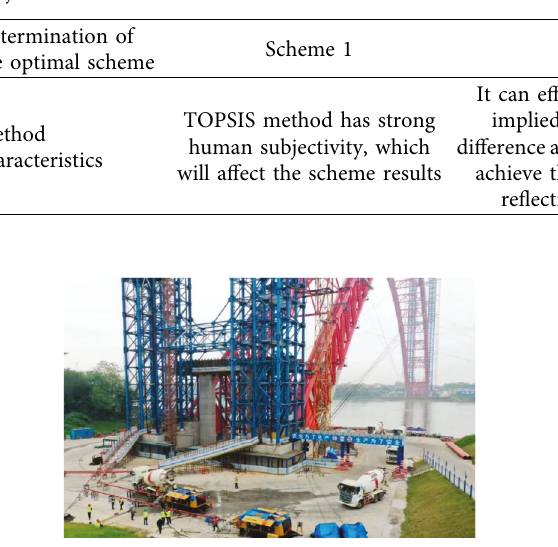
Figure 5: Schematic diagram of on-site concrete